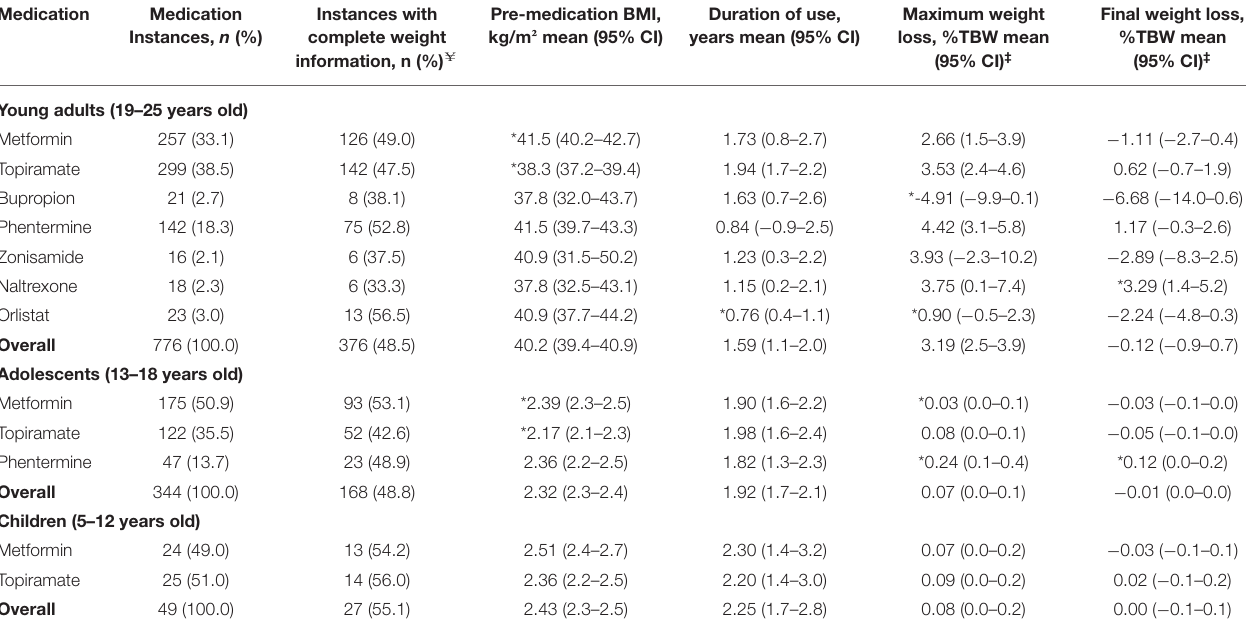
TABLE 8 | Medication characteristics and effect on weight loss, off-label patients—unadjusted analyses.